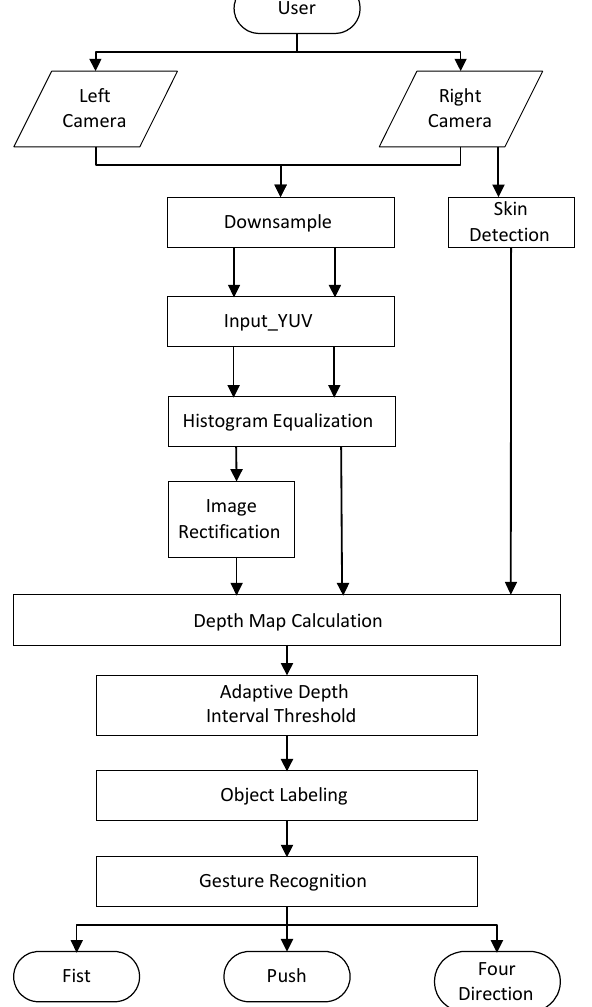
Figure 1. Design flow of the overall system.